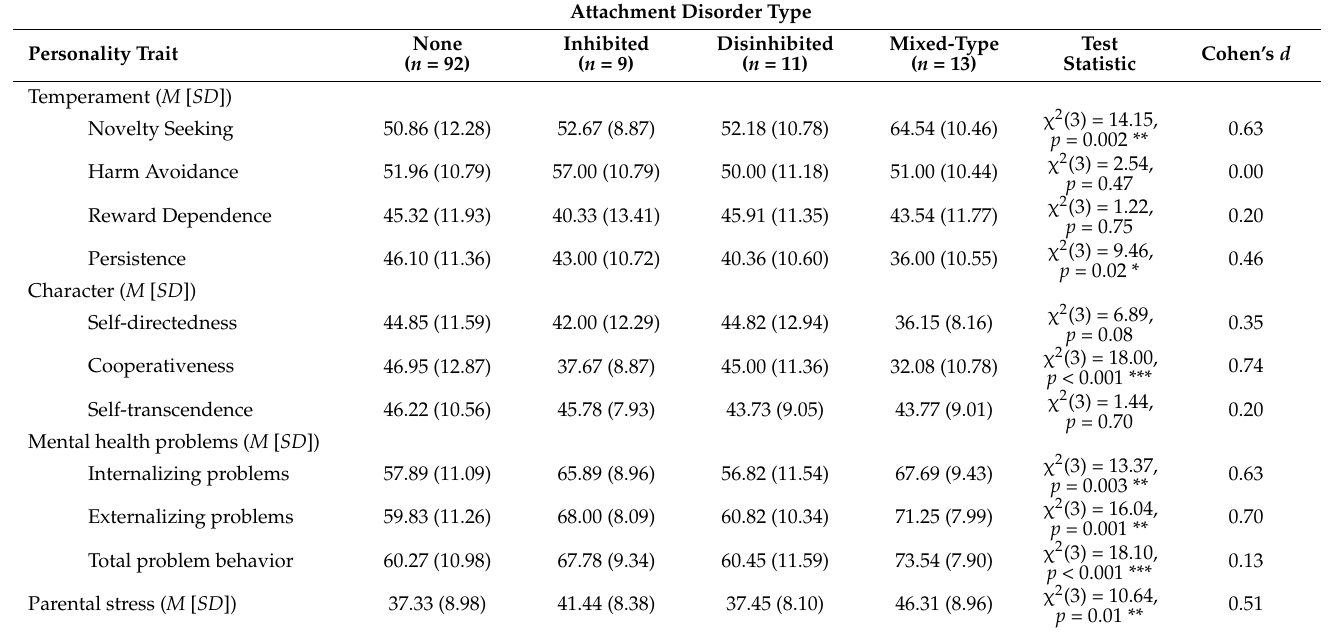
Table 3. Descriptive characteristics for temperament and character, mental health problems, and parental stress with attachment disorder